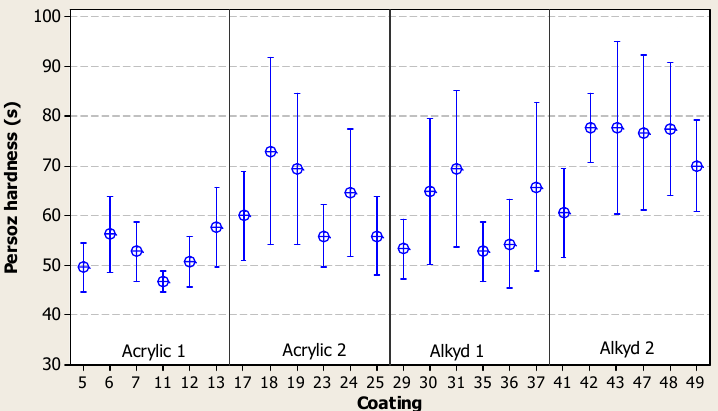
Figure 1. Mean Persoz hardness and confidence interval at 95% for the mean for the 24 coatings.